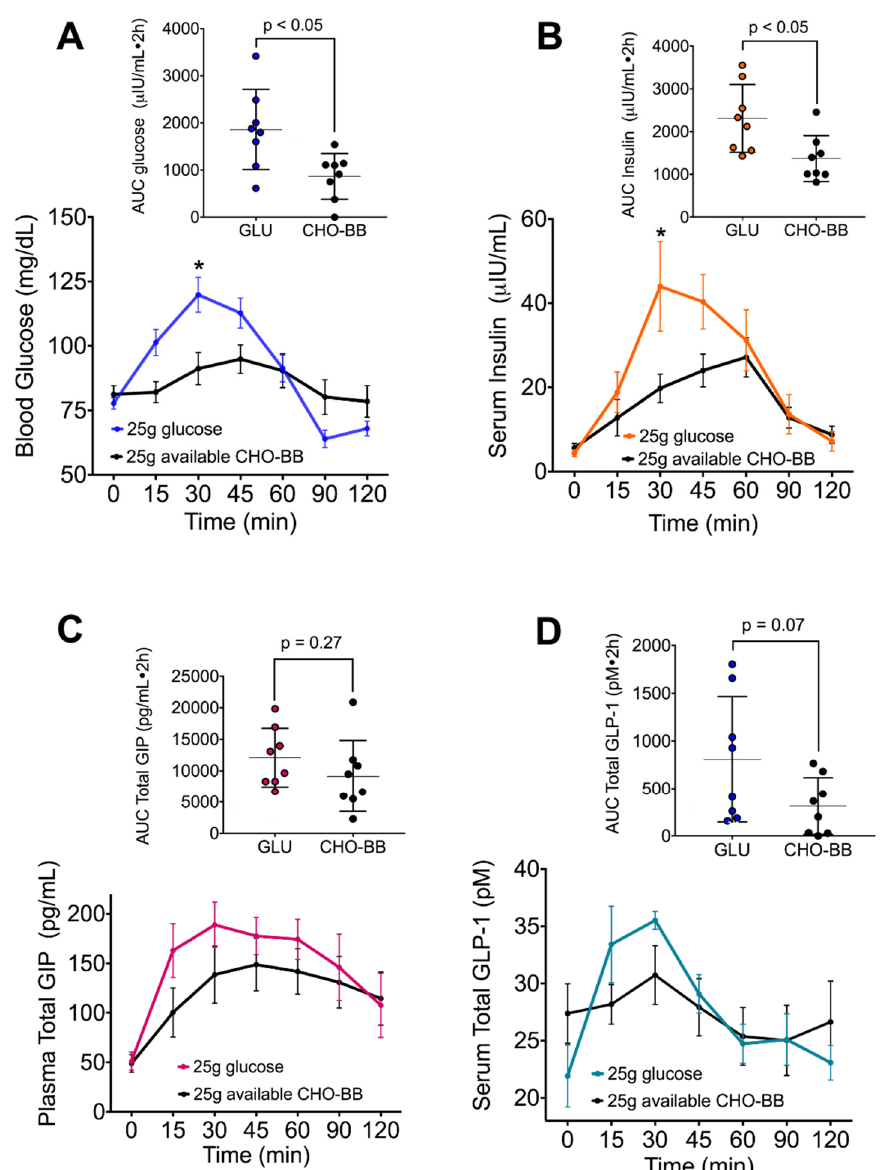
Figure 6. The consumption of 25 g of available carbohydrates from black bean attenuates serum glucose and postprandial insulin peaks. After consumption of 25 g of glucose or 25 g of available carbohydrates from black bean, blood samples were taken at di ff erent times over 2 h. ( A ) Serum glucose, ( B ) serum insulin, ( C ) total plasma GIP and ( D ) total serum GLP-1 in eight healthy subjects. For each graph, the area under the curve (AUC) was calculated and showed as an inset in each panel. Data are shown as mean ± SEM. Significant di ff erences were considered with p < 0.005.